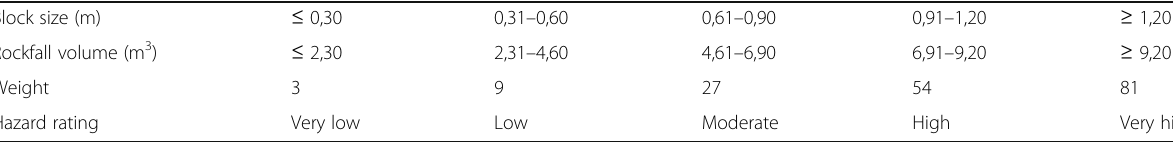
Table 8 The modified rock block size and rockfall volume classification Block size